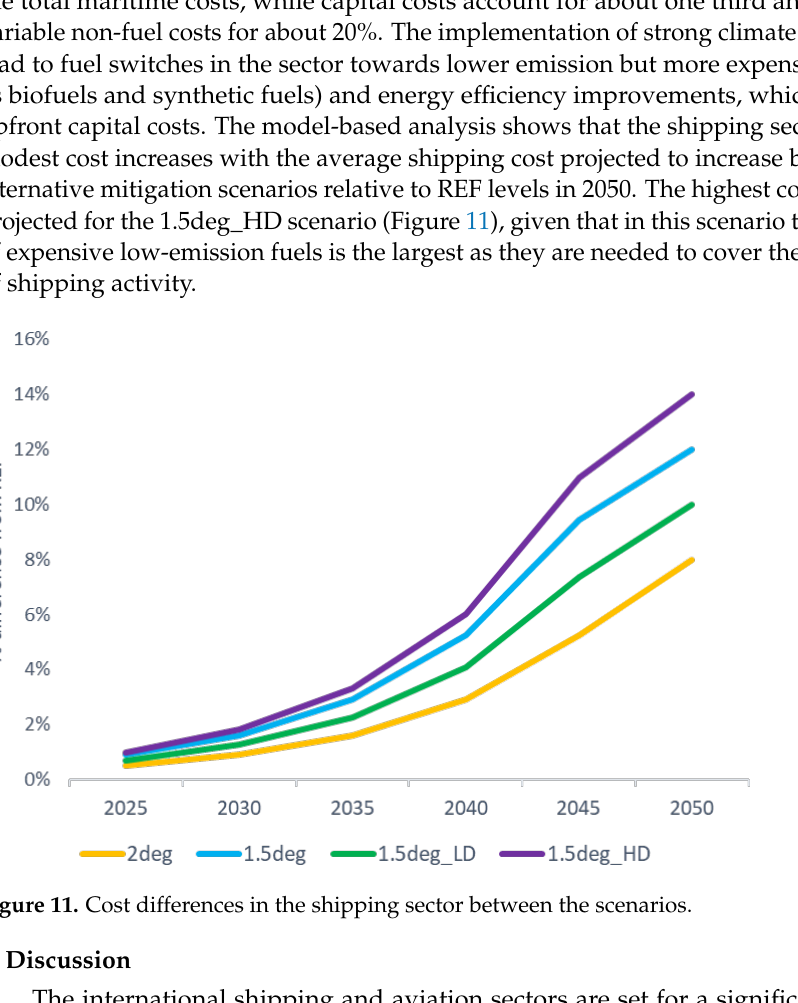
Figure 10. Energy consumption by fuel for international shipping in 2030 and in 2050.